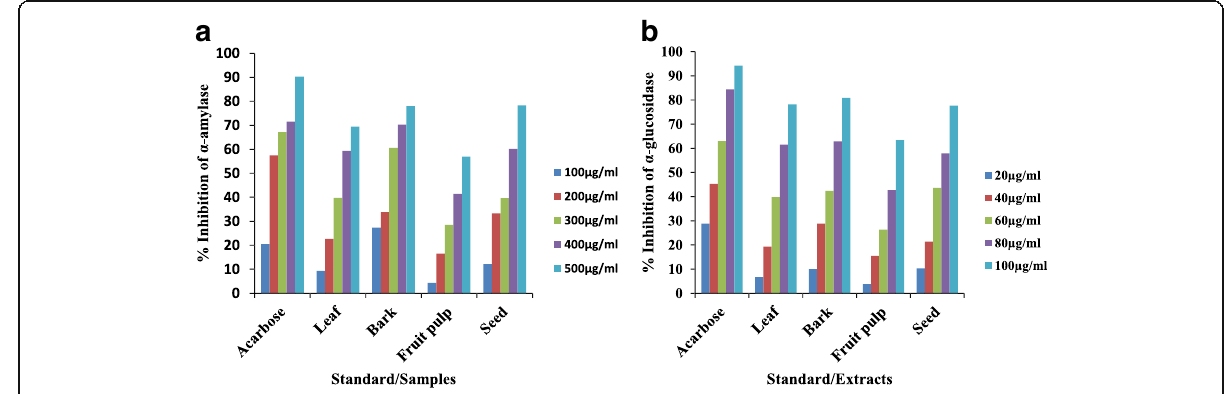
Fig. 3 a In vitro alpha amylase activity of S. caryophyllatum. b In vitro alpha-glucosidase activity of S.